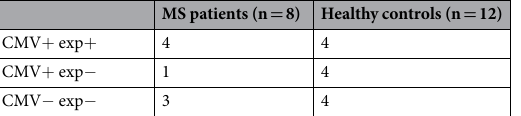
Table 2. Study subjects for in vitro CMV stimulation assay. MS, multiple sclerosis; CMV + / − ,